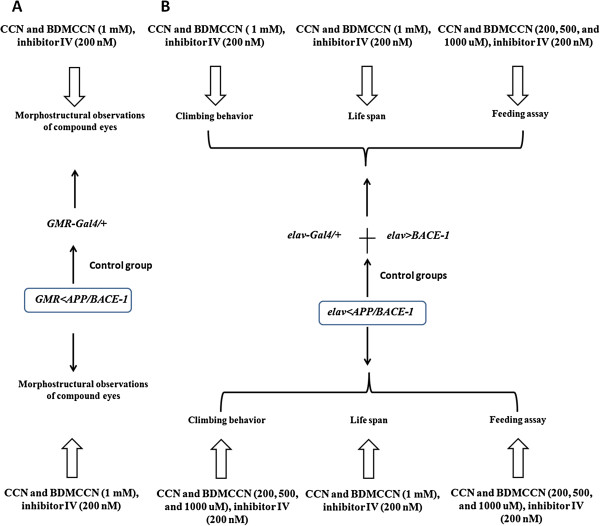
The schematism of experimental fly groups included in our study.GMR-Gal4 drives target human APP and BACE-1 genes expression in flies’ compound eyes, and morphostructural abservation changes of these compound eyes with the supplementation of compounds with different concentration, GMR-Gal4/+ as the control group (A), elav-Gal4 drives target genes co-expression in flies’ nervous system, observation behaviors including climbing, life span and feeding assay with the supplementation of compounds with different concentration, elav-Gla4/+ and elav < BACE-1 used as control groups (B).